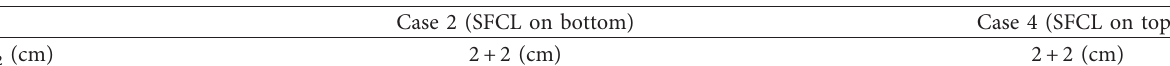
Table 5: Location of the